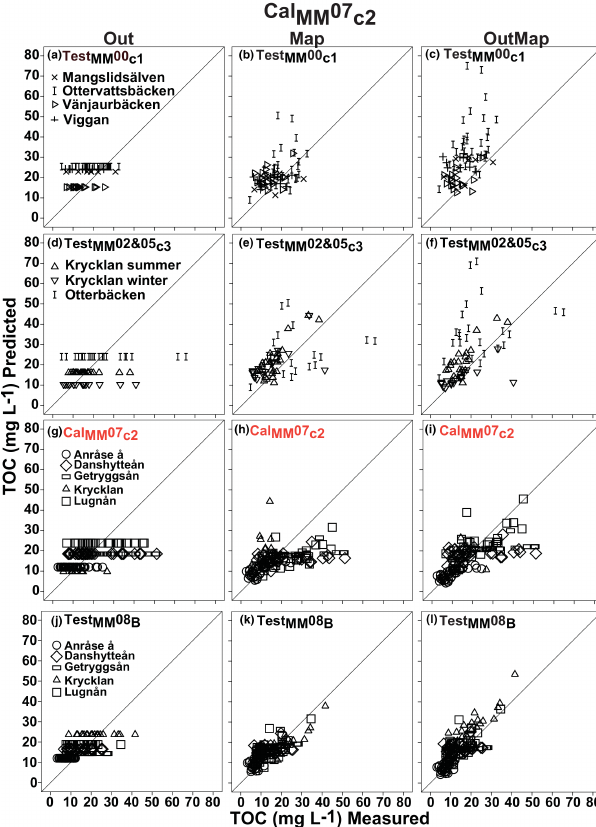
Figure 5. Scatterplots of measured headwaters with total organic carbon (TOC in mgL − 1 ) on the x axis, and the three different ver- sions of the mixed models Cal08 on the y axis: Out version on the left panel, OutMap version on the right panel and Map in-between. Data for year 2008 (Cal MM 08 c2 ) on the last row in red text, fol- lowed by Test data; first row 2000 data, second row 2002 & 2005 data and the third row is 2007 data. R. Anråse å indicated by cir- cles, R. Danshytteån by diamonds, R. Getryggsån by rectangles, R. Krycklan by triangles (winter 2005 by upside-down triangles), R. Lugnån by squares, R. Mangslidsälven by multiplication sign, R. Ottervattsbäcken by upside-down triangles, R. Vänjaurbäcken by right tilted triangles and R. Viggan by plus sign. The black line is the 1:1